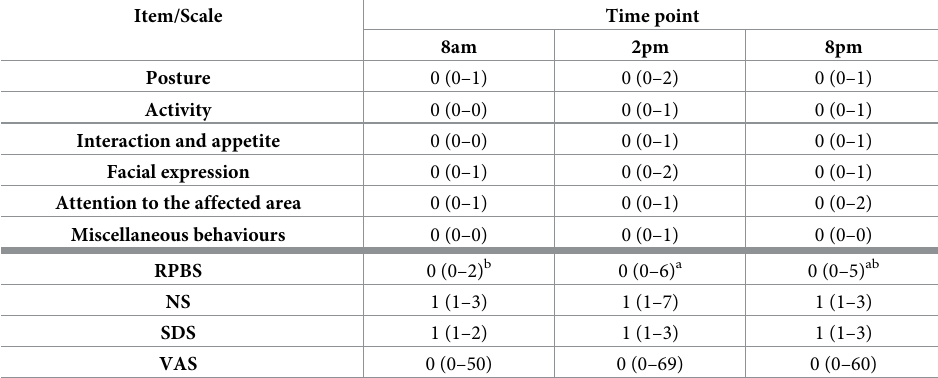
Table 9. Evaluation of RPBS and unidimensional scales between three different periods of the day.